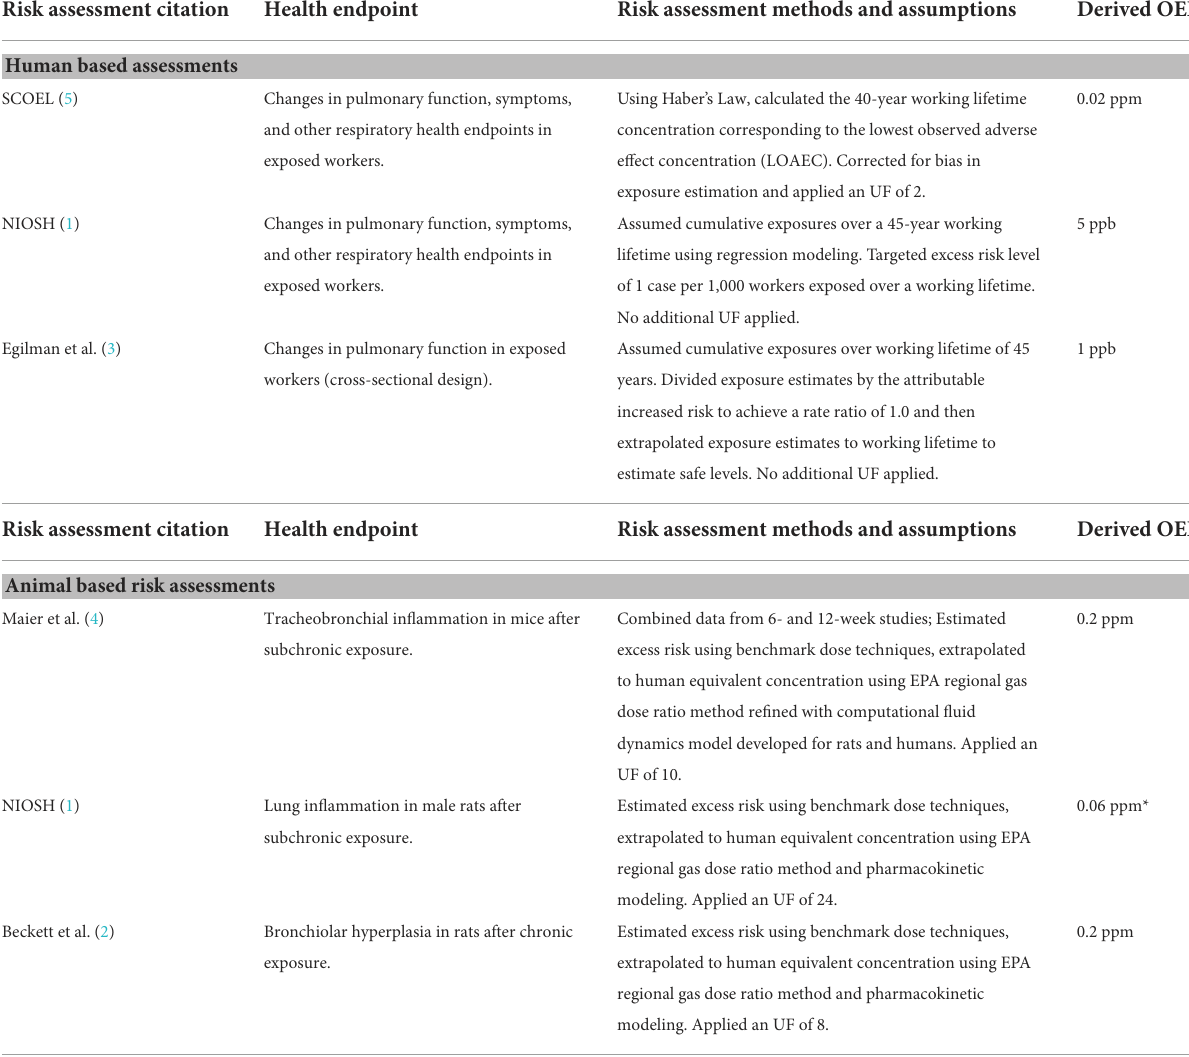
TABLE 2 Risk assessments based on human and animal studies of respiratory health effects from diacetyl